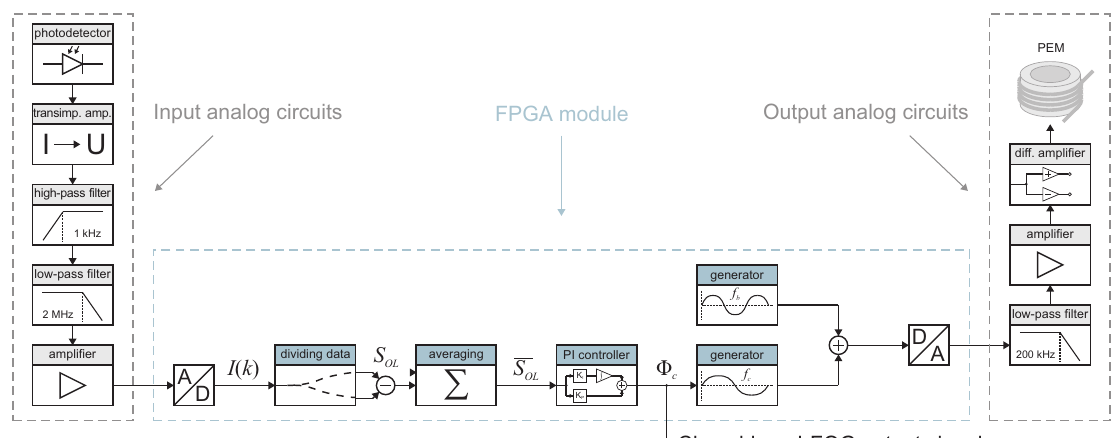
Figure 5. A diagram of the signal processing and the closed-loop control algorithm.